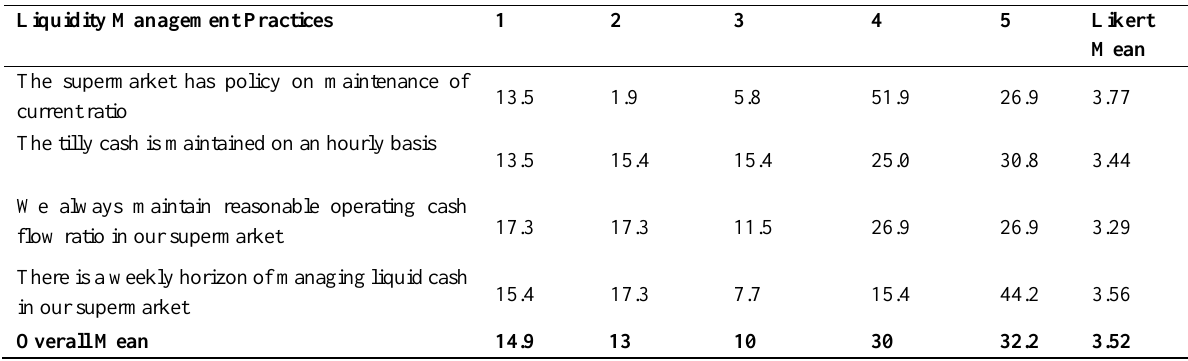
Table 3: Analysis of Liquidity Management Practices and Operational Performance Liquidity Management Practices